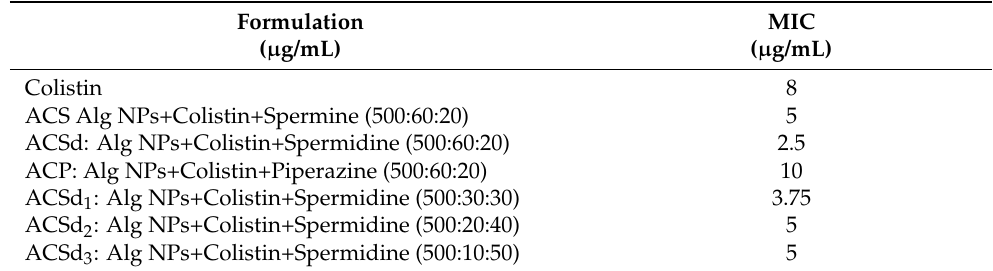
Table 4. MIC of colistin (in µ g/mL), alone and in combination with Alg NPs and polyamines, against Escherichia coli 184